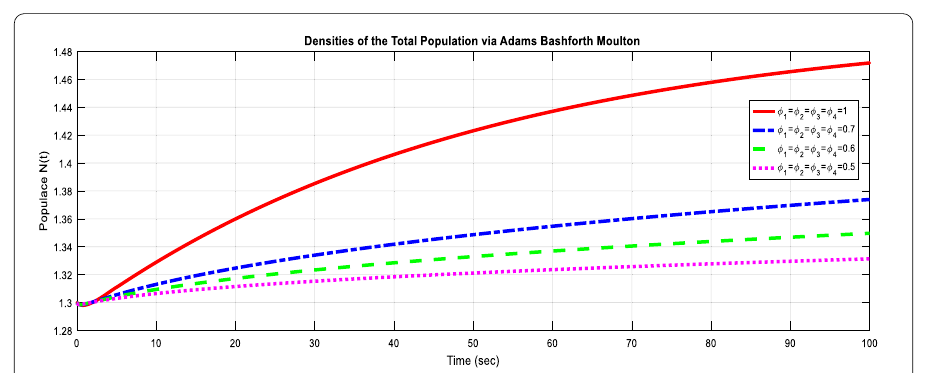
Figure 29 Dynamic of populace N ( t ) by varying the value of